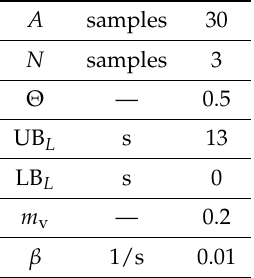
Table 2. Parameters used in the window-based